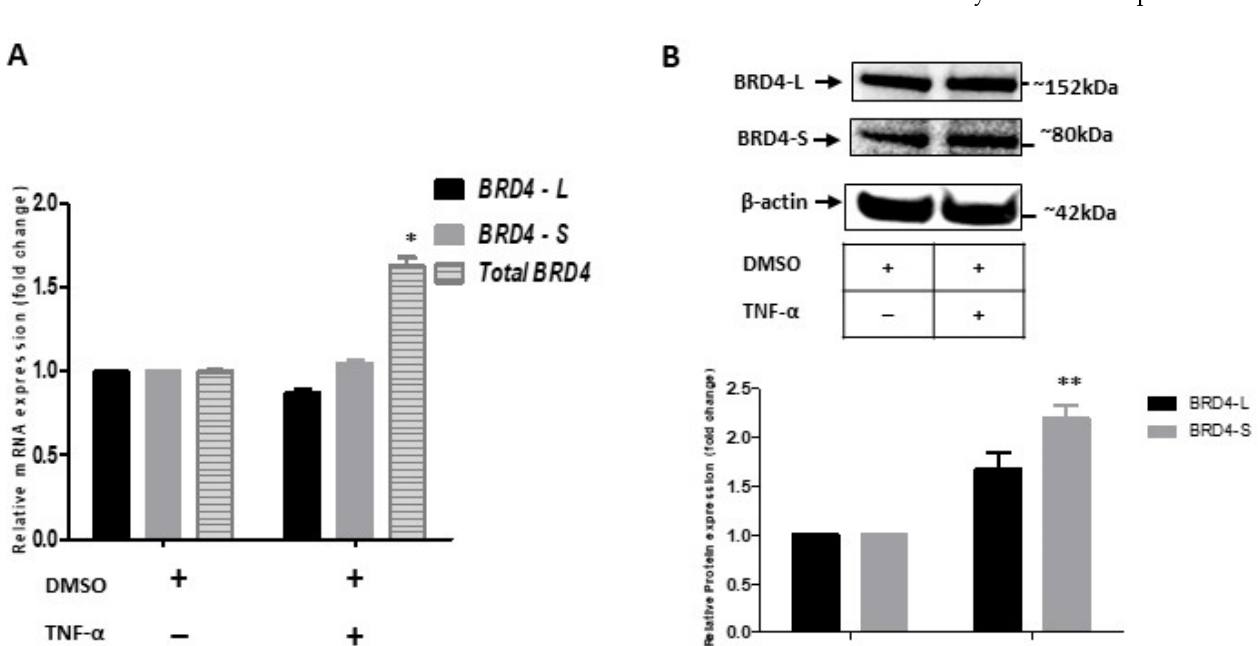
Figure 2. Expression analysis of BRD4 isoforms in HUVECs. ( A ) Bar graph showing relative mRNA levels of BRD4-Total normalized to house-keeping gene GAPDH. BRD4-L and BRD4-S isoforms normalized first to the house-keeping gene and then to BRD4-Total. ( B ) Western blot image and the corresponding relative quantification bar graph showing the protein expression of BRD4-L and BRD4-S. Immunoblot is stripped and reprobed with β -actin antibody. The β -actin (~42kDa) is used as a loading control. The band intensities of BRD4-L and BRD4-S are normalized to β -actin. ( A , B ) Two-way ANOVA with Bonferroni’s post-test used; values are mean ± SD of two biological replicates (** = p < 0.01 and * = p < 0.05).